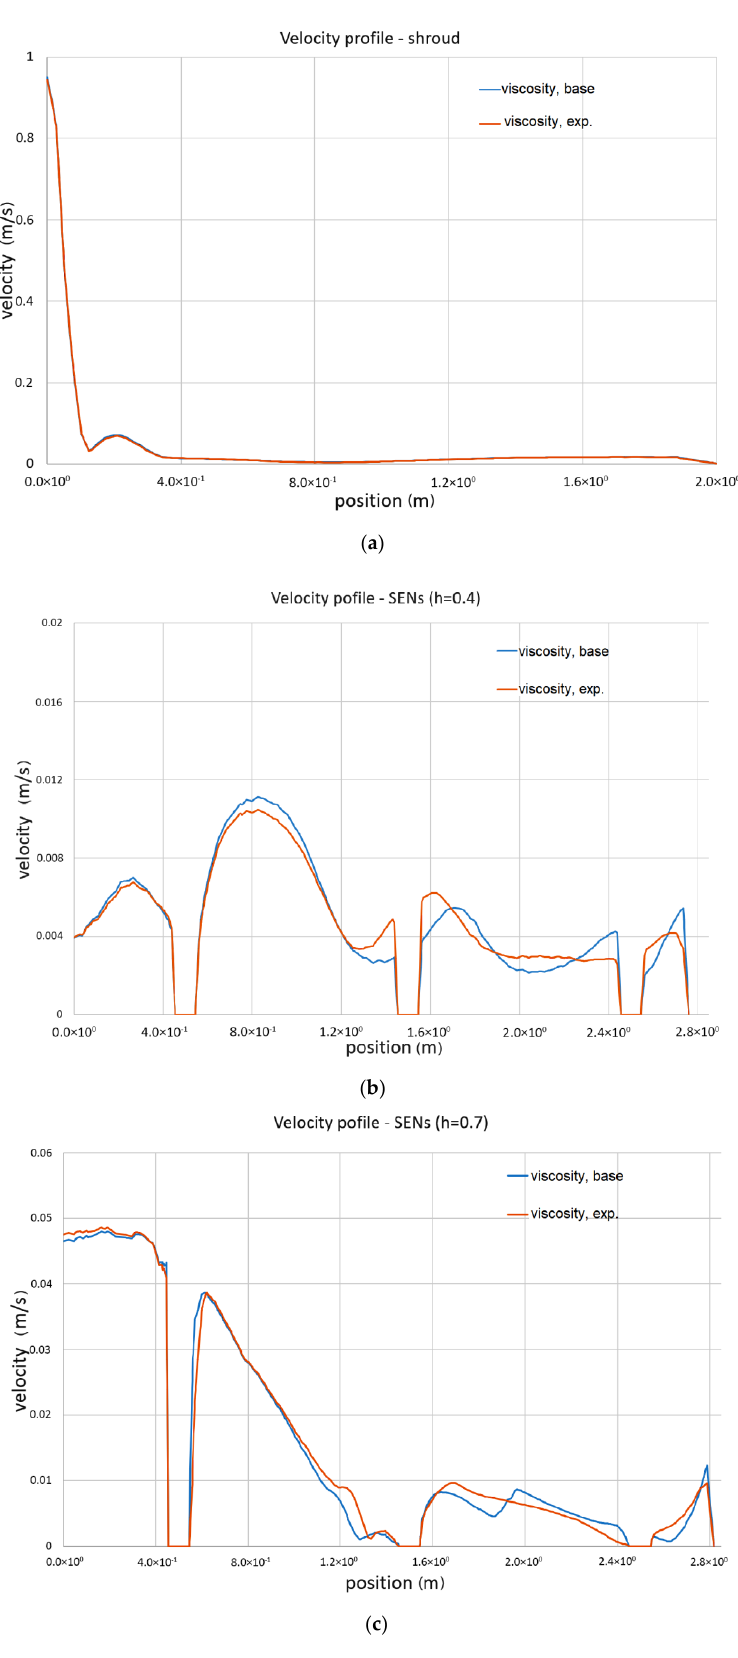
Figure 16. Liquid steel velocity value on lines passing through shroud and outflows (SENs); ( a ) shroud; ( b ) SENs, h=0.4; ( c ) SENs, h=0.7.